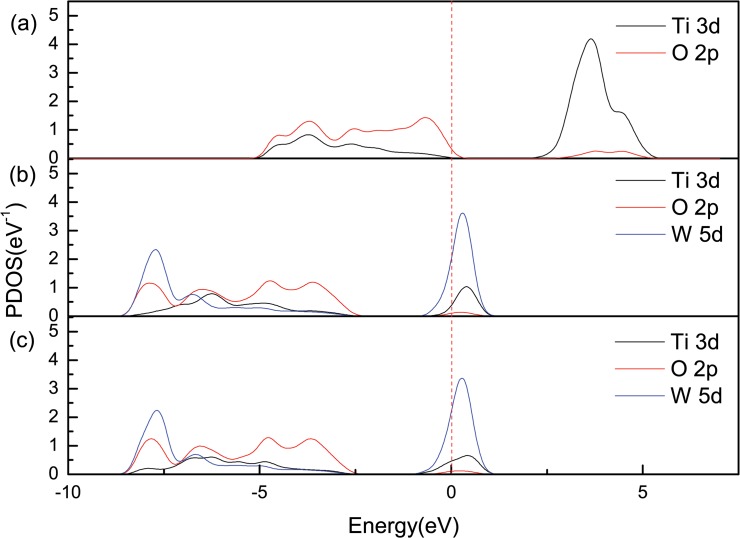
PDOS for pure and W-doped anatase TiO2.(A) pure anatase TiO2 unit cell, (B) Ti0.97917W0.02083O2 supercell, (C) Ti0.96875W0.03125O2 supercell.